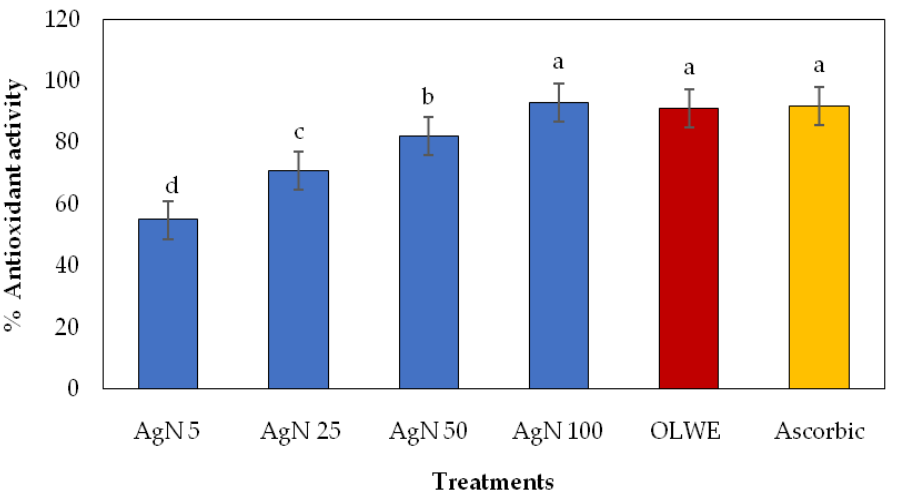
Figure 3. DPPH free radical scavenging activity of the AgNPs and OLWE compared to ascorbic acid. Lowercase letters above columns indicate significant differences.